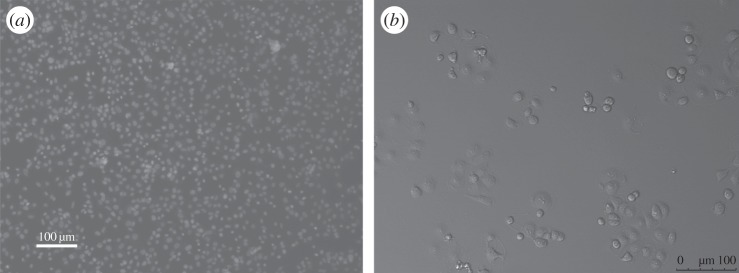
Images from two different in vitro cell biology experiments. (a) A distribution of 3T3 mouse fibroblast cells [19] which appears to be spatially uniform. The size of the image is 870×649 μm or 1976 pixels×1475 pixels, giving 0.44 μm pixel−1. (b) A distribution of MDA-MB-231 breast cancer cells [20] which appears to be highly clustered. The size of the image is 622×464 μm or 523 pixels×390 pixels, giving 1.19 μm pixel−1. Note that the objects in (a) correspond to cells which have been treated with a nucleus stain, whereas the objects in (b) correspond to cells without any nucleus stain.